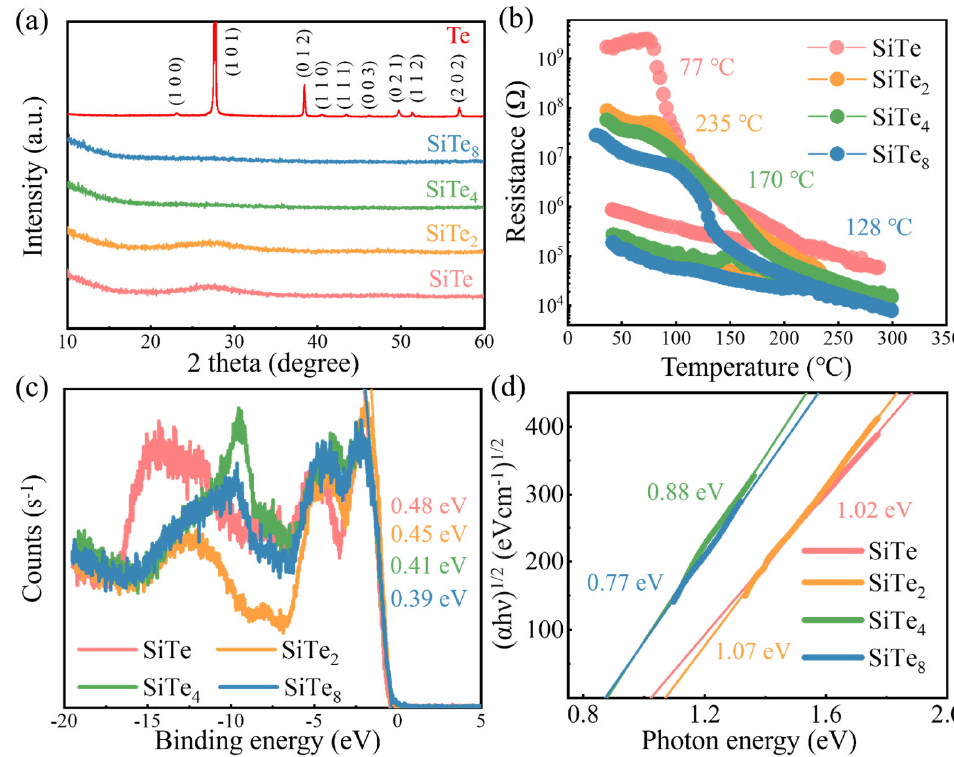
Figure 5. Characterization of Si − Te films. ( a ) XRD results of SiTe, SiTe 2 , SiTe 4 , SiTe 8 and Te films. ( b ) R-T results of films with four Si − Te compositions. ( c ) XPS valence band spectrum of SiTe, SiTe 2 , SiTe 4 , SiTe 8. ( d ) ( α h ν ) 1/2 versus h ν interprets the bandgap of four compositions.